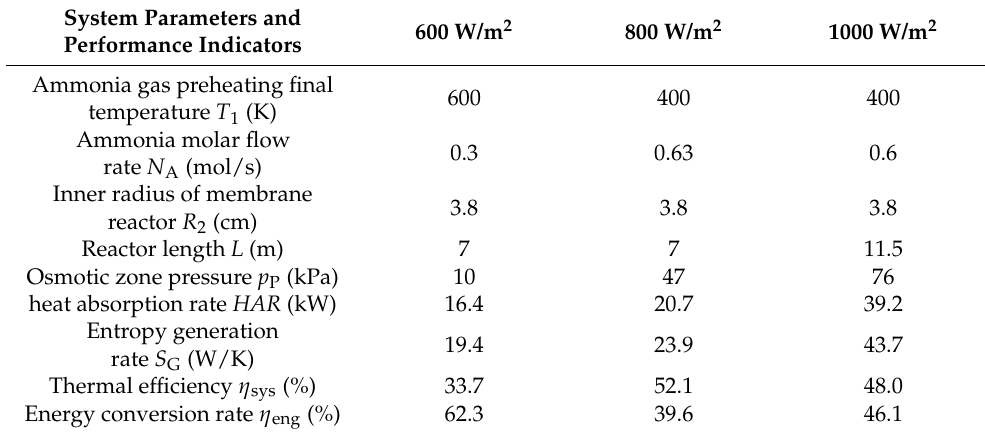
Table 5. Parameters of TOPSIS optimal system in four-objective optimization under different light